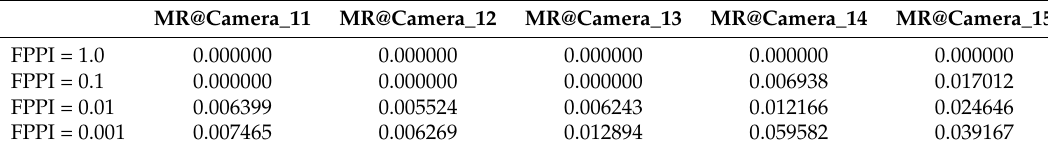
Table 4. Accuracy table @ Cameras_11–15, informed-filters.